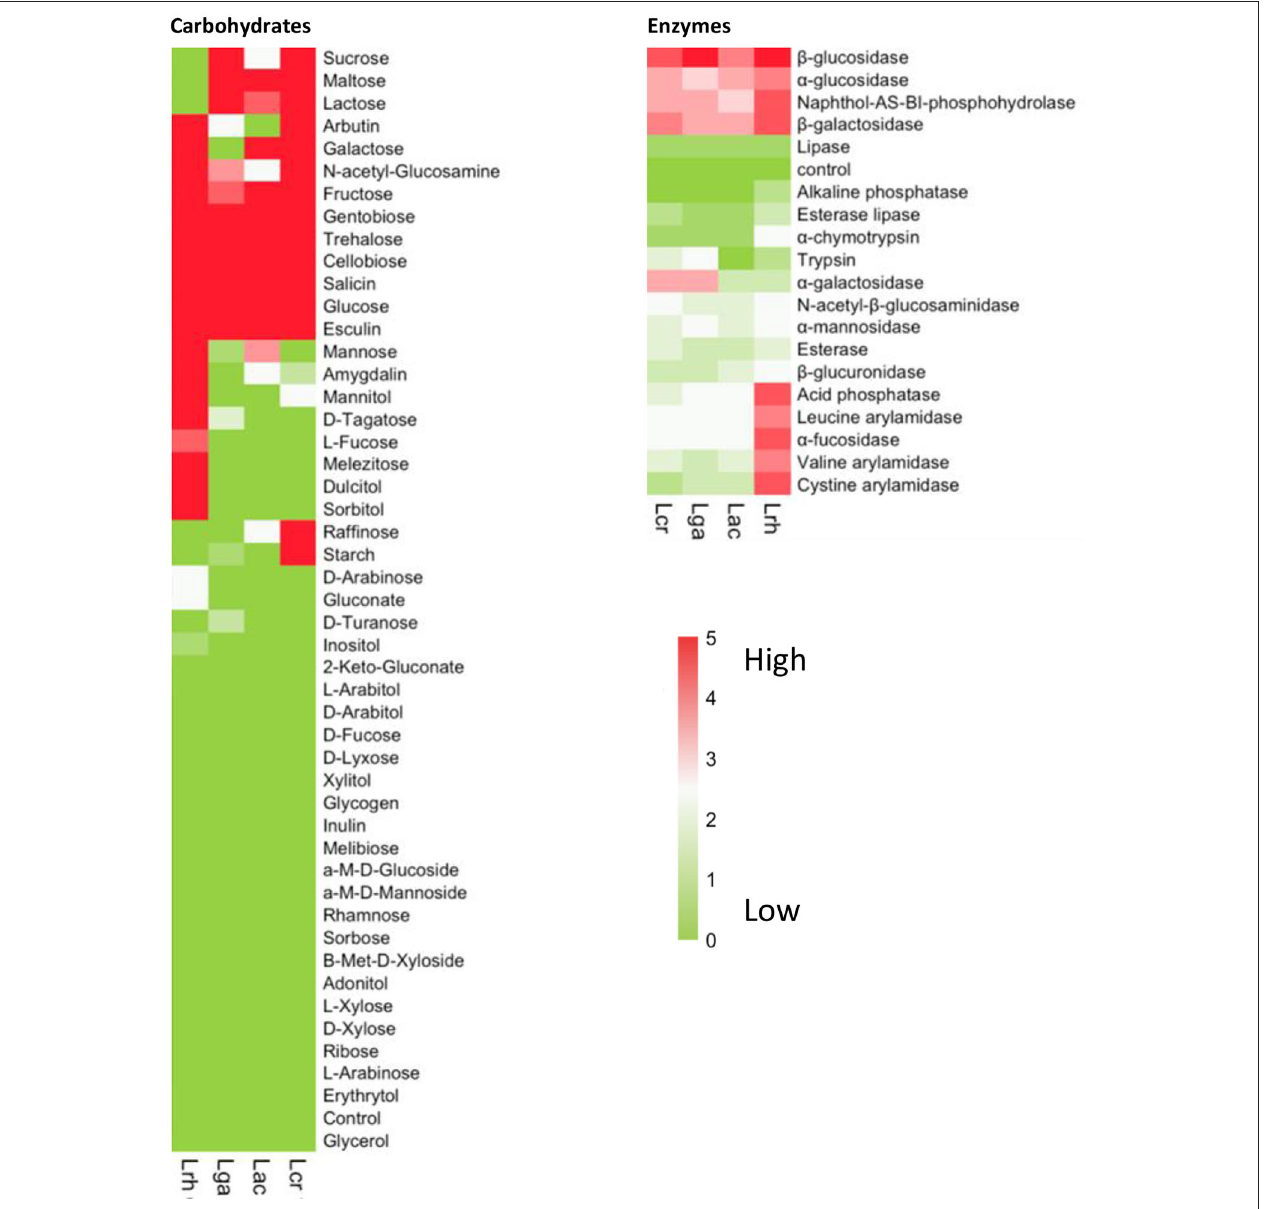
FIGURE 2 | Carbohydrate and enzyme profiles of Lactobacillus strains. Carbohydrate utilization and enzymatic activity were determined using API assays for the four strains, namely, L. acidophilus NCFM (Lac), L. crispatus NCK1351 (Lcr), L. gasseri NCK1342 (Lga), and L. rhamnosus GG (Lrh). The heat maps show the mean values of two biological replicates with the values scored according to the manufacturer’s instructions. The values range from 0 to 5 and are assigned to the standard color where zero represents no reaction and 5 represents a reaction of maximum intensity. The relative activity may be estimated from color strength.